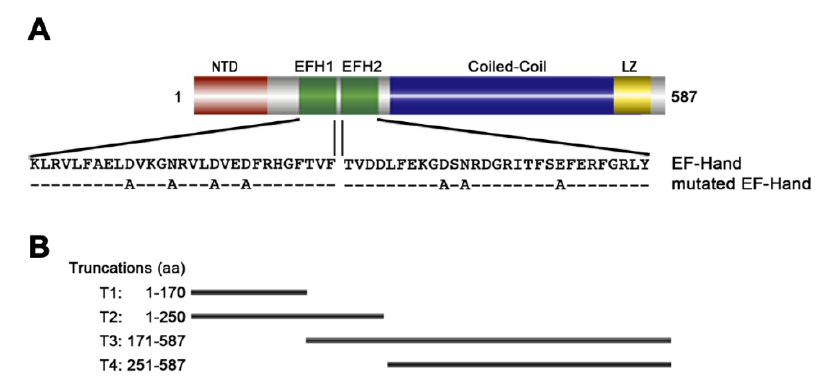
Figure 2. Tb BILBO1 domains: ( A ) The Tb BILBO1 protein consists of 587 amino acids, with a ubuquitin-like N-terminal domain (NTD, that ranges from amino acids 1–110), two EF-hand calcium-binding domains (EFH1 and EFH2, that ranges from amino acids 185–249), a long predicted CC domain and a leucine zipper (LZ, ranging from amino acids 533–578). The mutations in the EF-hand calcium binding domains are indicated below the wild-type amino acid sequence. Mutation studies have shown that the EF-hand domains modulate the morphology of polymers formed by Tb BILBO1; ( B ) The main truncations used to characterize polymer formation capacities are shown schematically below the secondary structure and labeled as truncation (T), from T1–T4.